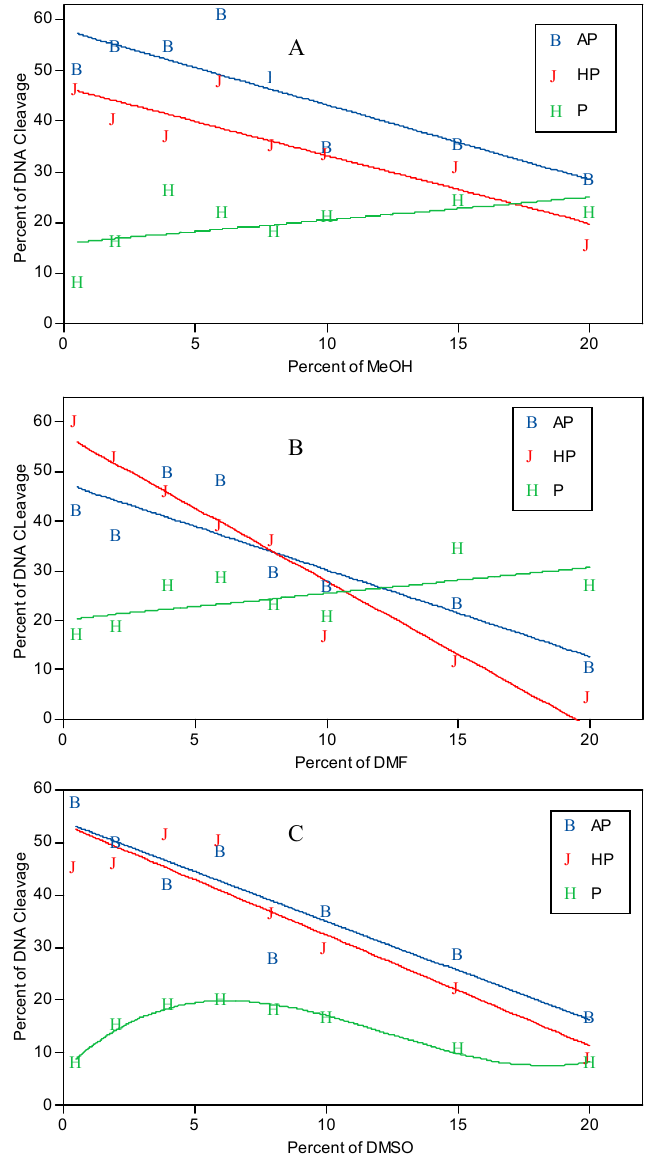
Figure 2. Effect of organic solvents on the percent of DNA photocleavage induced by 1-aminopyrene (AP, 6 µM), 1-hydroxypyrene (HP, 0.6 µM) and pyrene (P, 60 µM). The solvents are with a certain percentage of methanol (MeOH, panel A), dimethylformamide (DMF, panel B) and dimethylsulfoxide (DMSO, panel C) in 10 mM phosphate buffer at pH 7.0. The error for each point is about ±20%. The straight lines are best linear fits of the data except for pyrene in DMSO, which was just a smooth line connecting of all the data